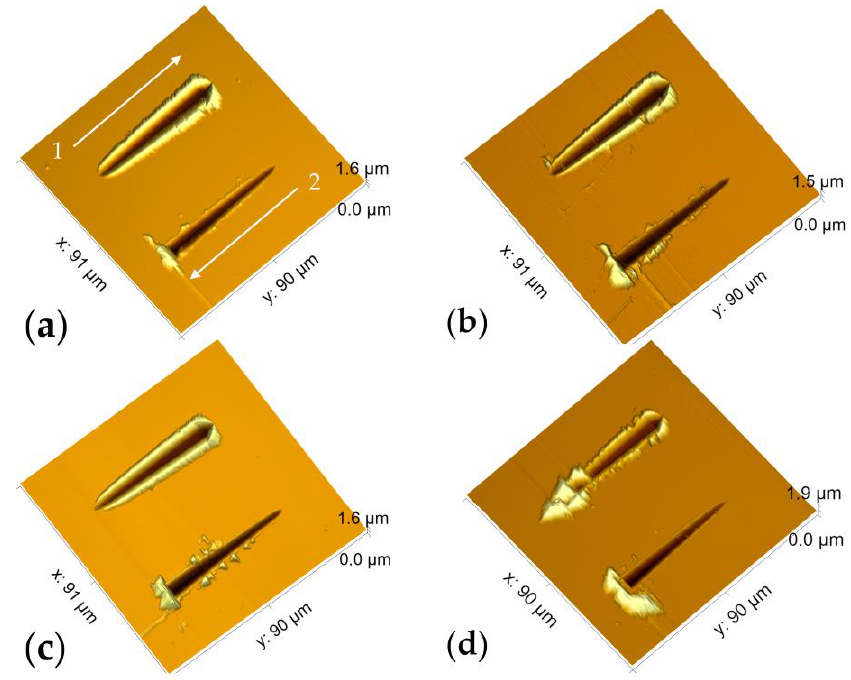
Figure 15. AFM images of scratch traces for PECVD BC x N y O z films deposited at varied temperature: ( a ) 373, ( b ) 423, ( с ) 473, and ( d ) 523, K. Indenter orientations: 1—edge-forward and 2—face-forward. ( a ) 373, ( b ) 423, ( c ) 473, and ( d ) 523, K. Indenter orientations: 1—edge-forward and